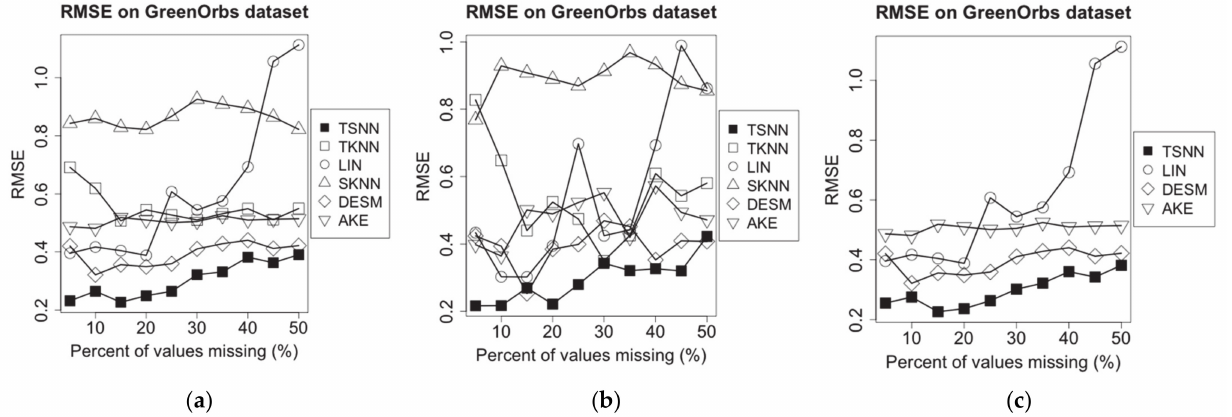
Figure 11. RMSE of imputation algorithms on humidity data of GreenOrbs dataset for the three scenarios: ( a ) temperature NA and humidity not NA, ( b ) temperature NA and humidity 50% NA and ( c ) temperature NA and humidity NA.